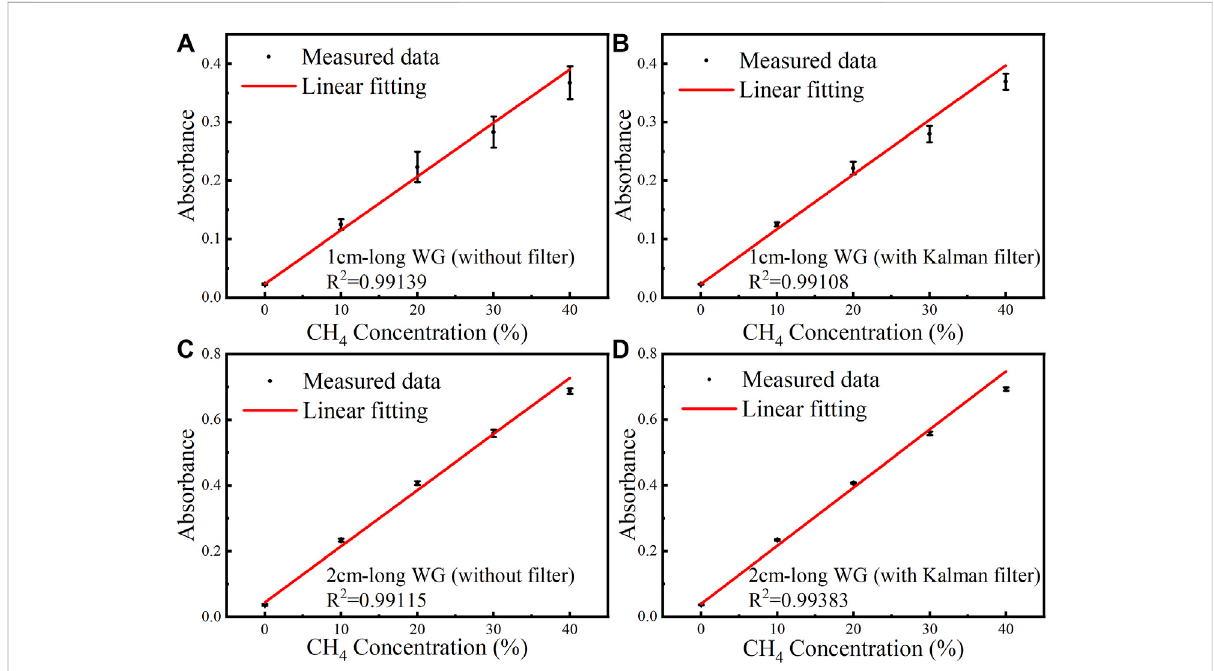
FIGURE 4 Under different CH 4 concentration levels of 0, 10, 20, 30 and 40%, measured data and linear fi tting curve of the absorbance versus CH 4 concentration for the 1 cm-long waveguide (A) without Kalman fi lter and (B) with Kalman fi lter. Measured data and linear fi tting curve of the absorbance versus CH 4 concentration for the 2 cm-long waveguide (C) without Kalman fi lter and (D) with Kalman fi